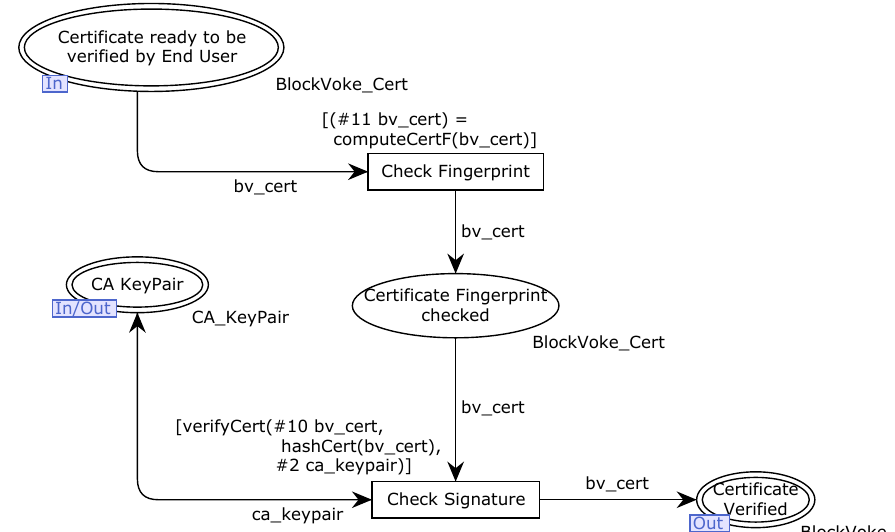
Figure 9. ‘Verify Certificate‘ sub-module of the BlockVoke CPN